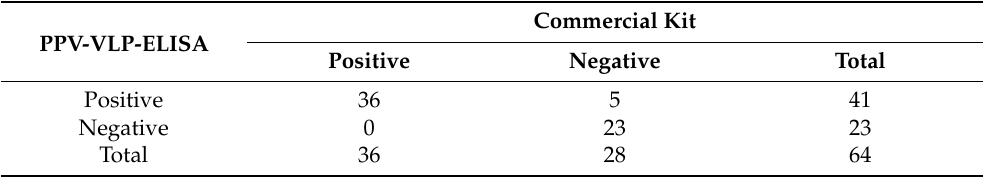
Table 2. Comparison of the PPV-VLP-ELISA with the commercial PPV ELISA kit for detection of anti-PPV antibodies.